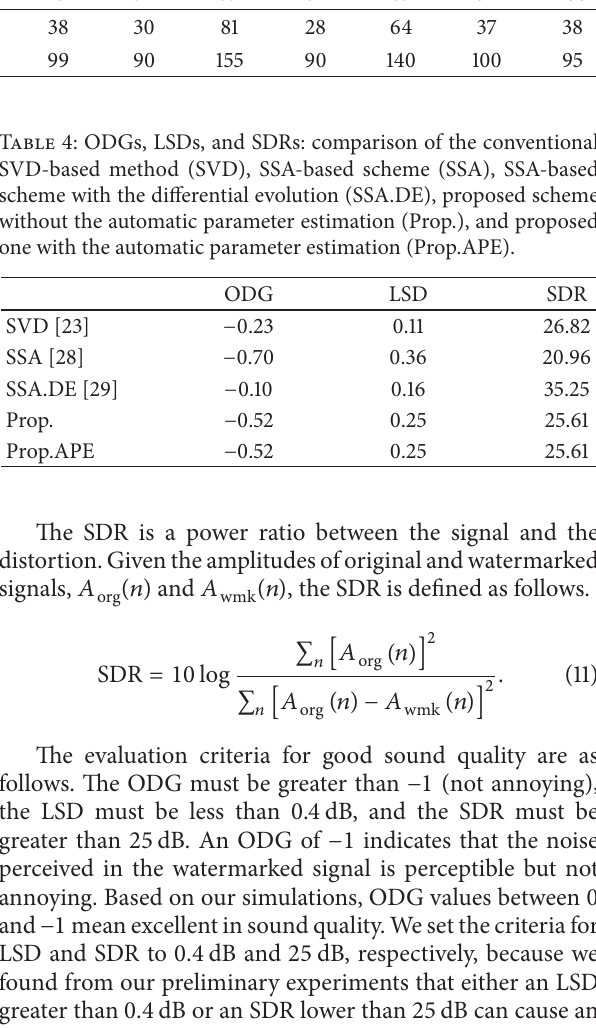
Table 3: Estimated parameters 𝑢 and 𝑙 obtained from the automatic parameter estimation in the extraction process. 01 07